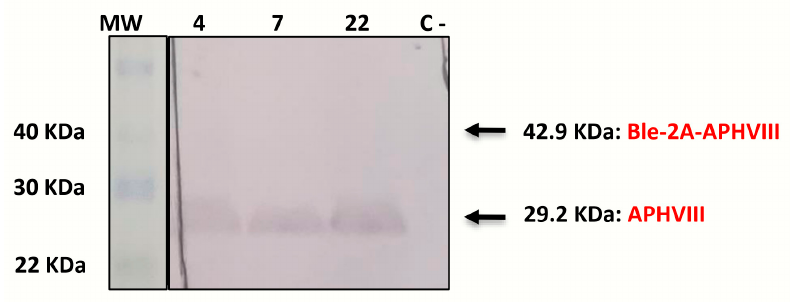
Figure 4. Immunoblot analysis showing the APHVIII protein product from C. reinhardtii cells transformed with the plasmid Phyco69BLE. Total soluble cell protein extracts (60 µg) of three Chlamydomonas transformants (#4, #7, #22) and one control untransformed Chlamydomonas culture (C-) were fractionated with SDS-PAGE, transferred to a PVDF membrane and probed with rabbit anti-APHVIII polyclonal antibodies and alkaline phosphatase-conjugated goat anti-rabbit IgG, as indicated in materials and methods. MW lane: Protein molecular weight markers.